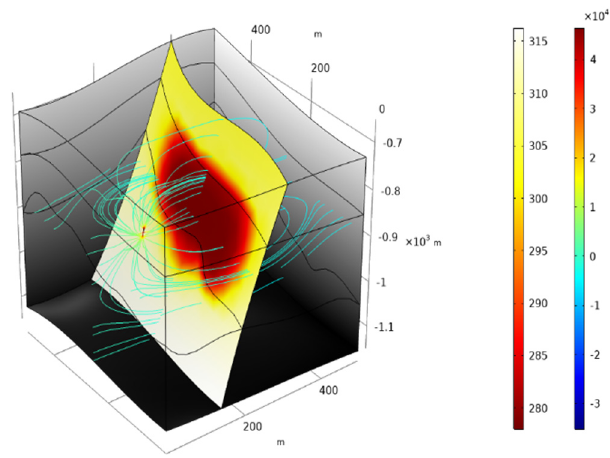
Figure 4. Temperature distribution and streamlines for GPG after 10 years (two color scales: left , temperature; right , pressure).